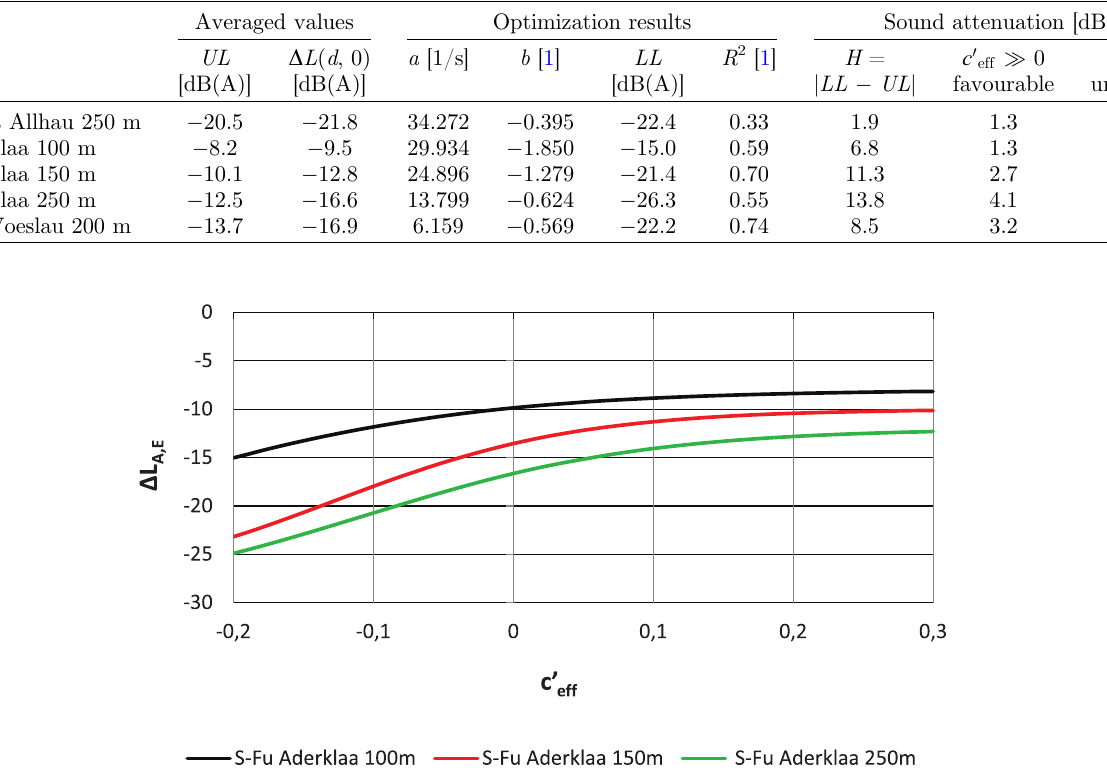
function (Fig. 14). The constant values for large and small gradients